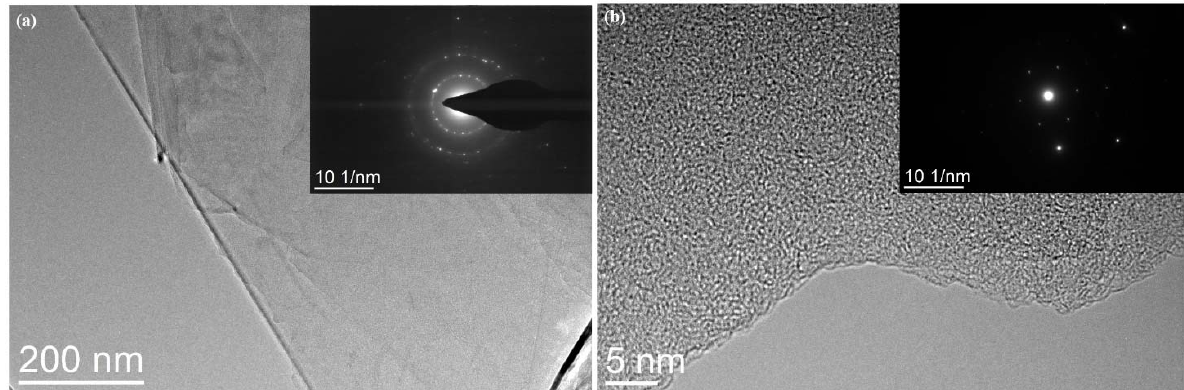
Figure 4. SEM of GNPs: ( a ) before dispersion; ( b ) after dispersion.